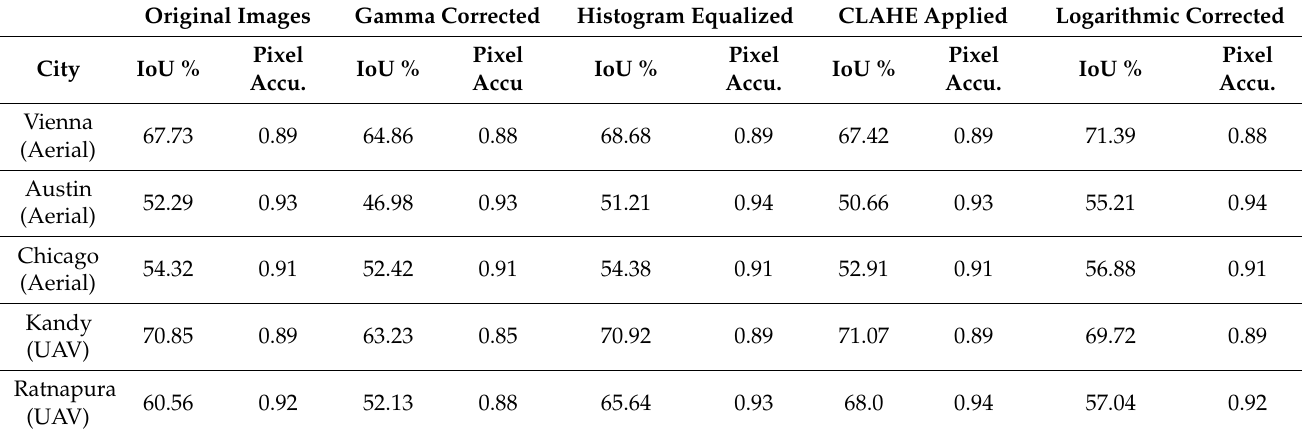
Table 5. Accuracy of the model with different image-enhancing algorithms (highest IoU value for each city is bolded). Original Images